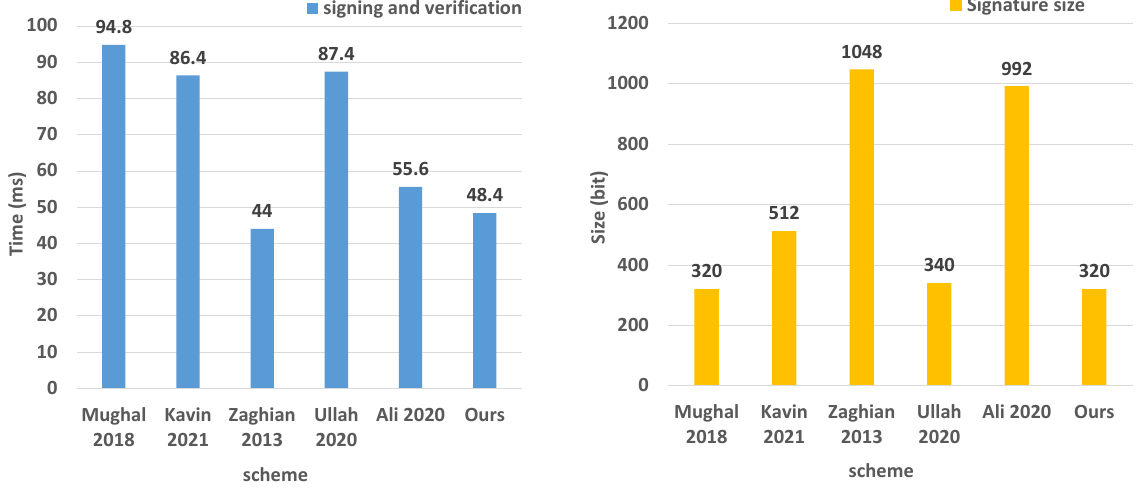
Figure 3. Comparison of computational and communication costs of our proposal with